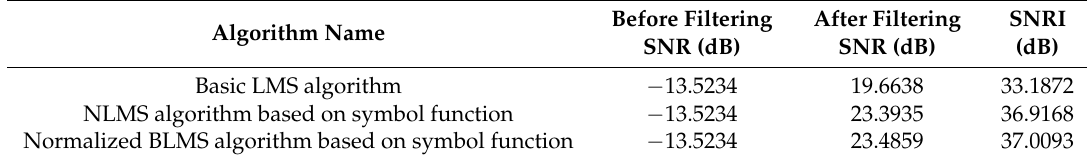
Table 2. SNR changes of MIT-BIH ECG with PLI before and after denoising.